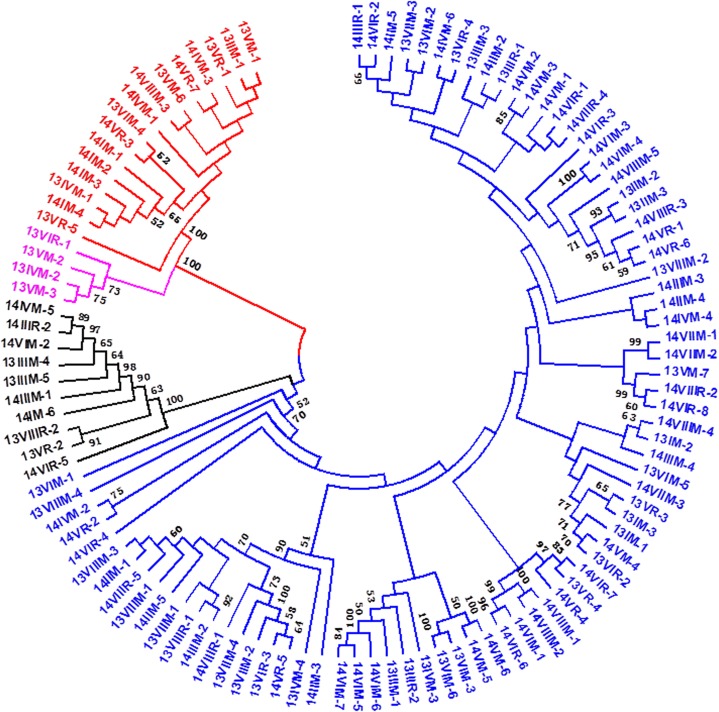
Neighbor-joining phylogenetic tree based on the nonrecombinant nucleotide sequence of S7 from different RBSDV isolates.The number of bootstrap replicates was set to 1000. Only bootstrap values > 50% are shown. Red lines represent the isolates that clustered into subgroup AI; pink lines represent the isolates that clustered into subgroup AII; black lines represent the isolates that clustered into subgroup BI; blue lines represent the isolates that clustered into subgroup BII.